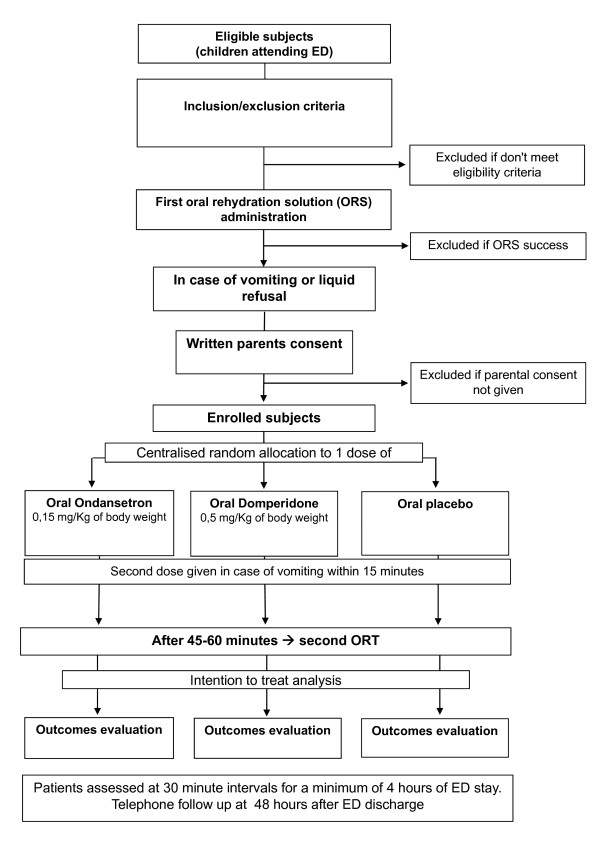
Study flow chart